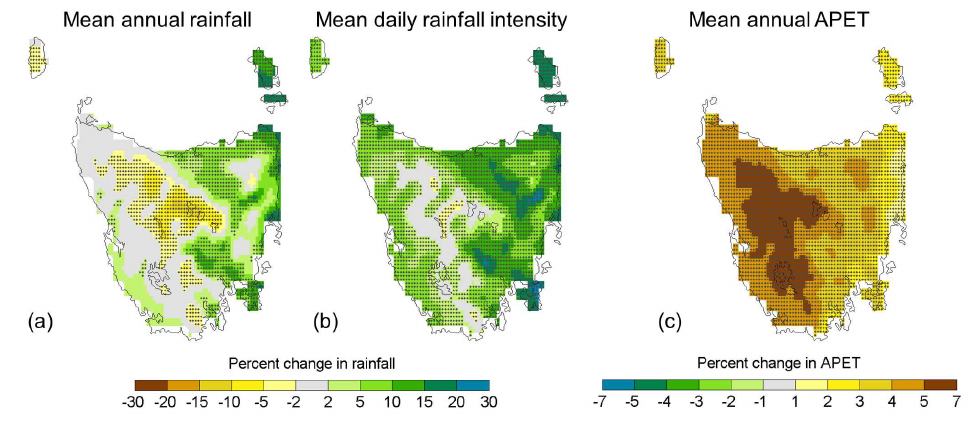
Fig. 10. Change in rainfall and APET from 1961–1990 to 2070–2099. (a) Change in mean annual rainfall. (b) Change in mean daily rainfall intensity for rain days > 1mm. (c) Change in mean annual APET. All plots are calculated from the average of the six RCM simulations. Stippling shows regions where at least five of the six RCM simulations agree on the sign of